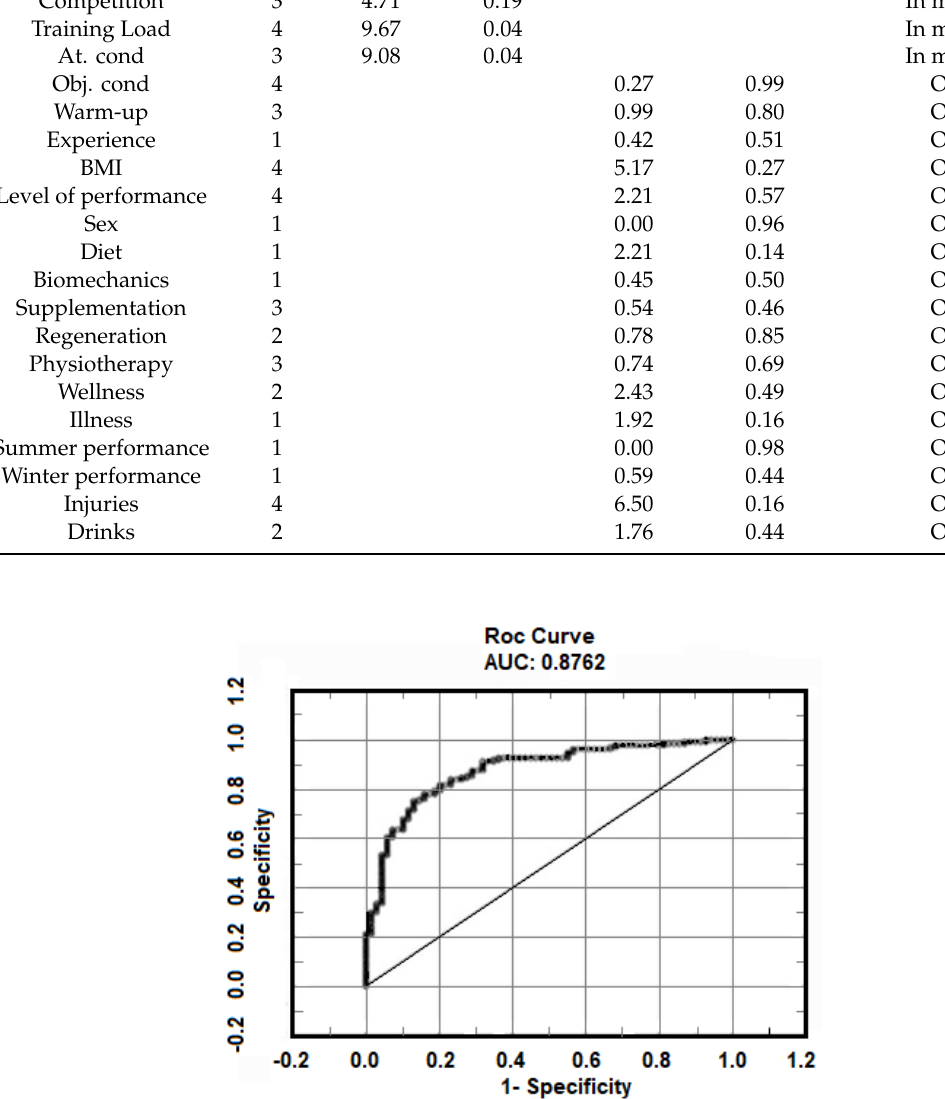
Table 3. The classification matrix for model M.